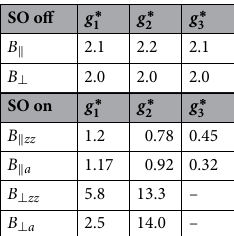
Table 2. Effective Landé factors g*.